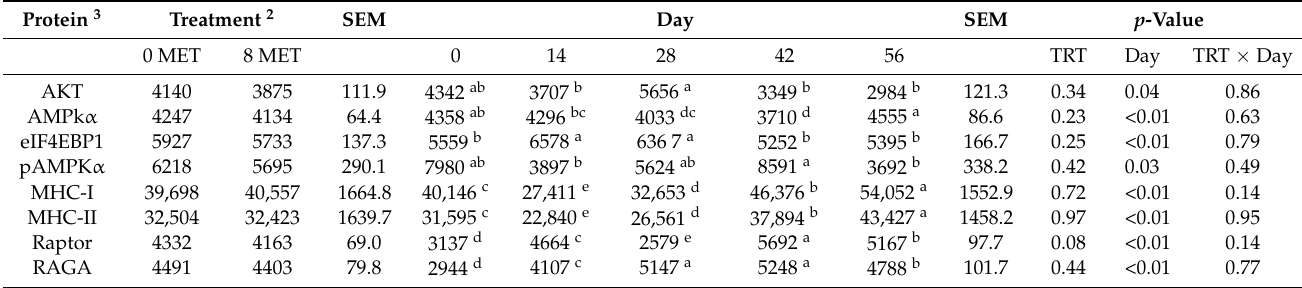
Table 8. Effect of encapsulated amino acids on relative protein abundances of AKT, AMPK α , eIF4EBP1, pAMPK α , Raptor, and RAGA proteins in longissimus tissue 1